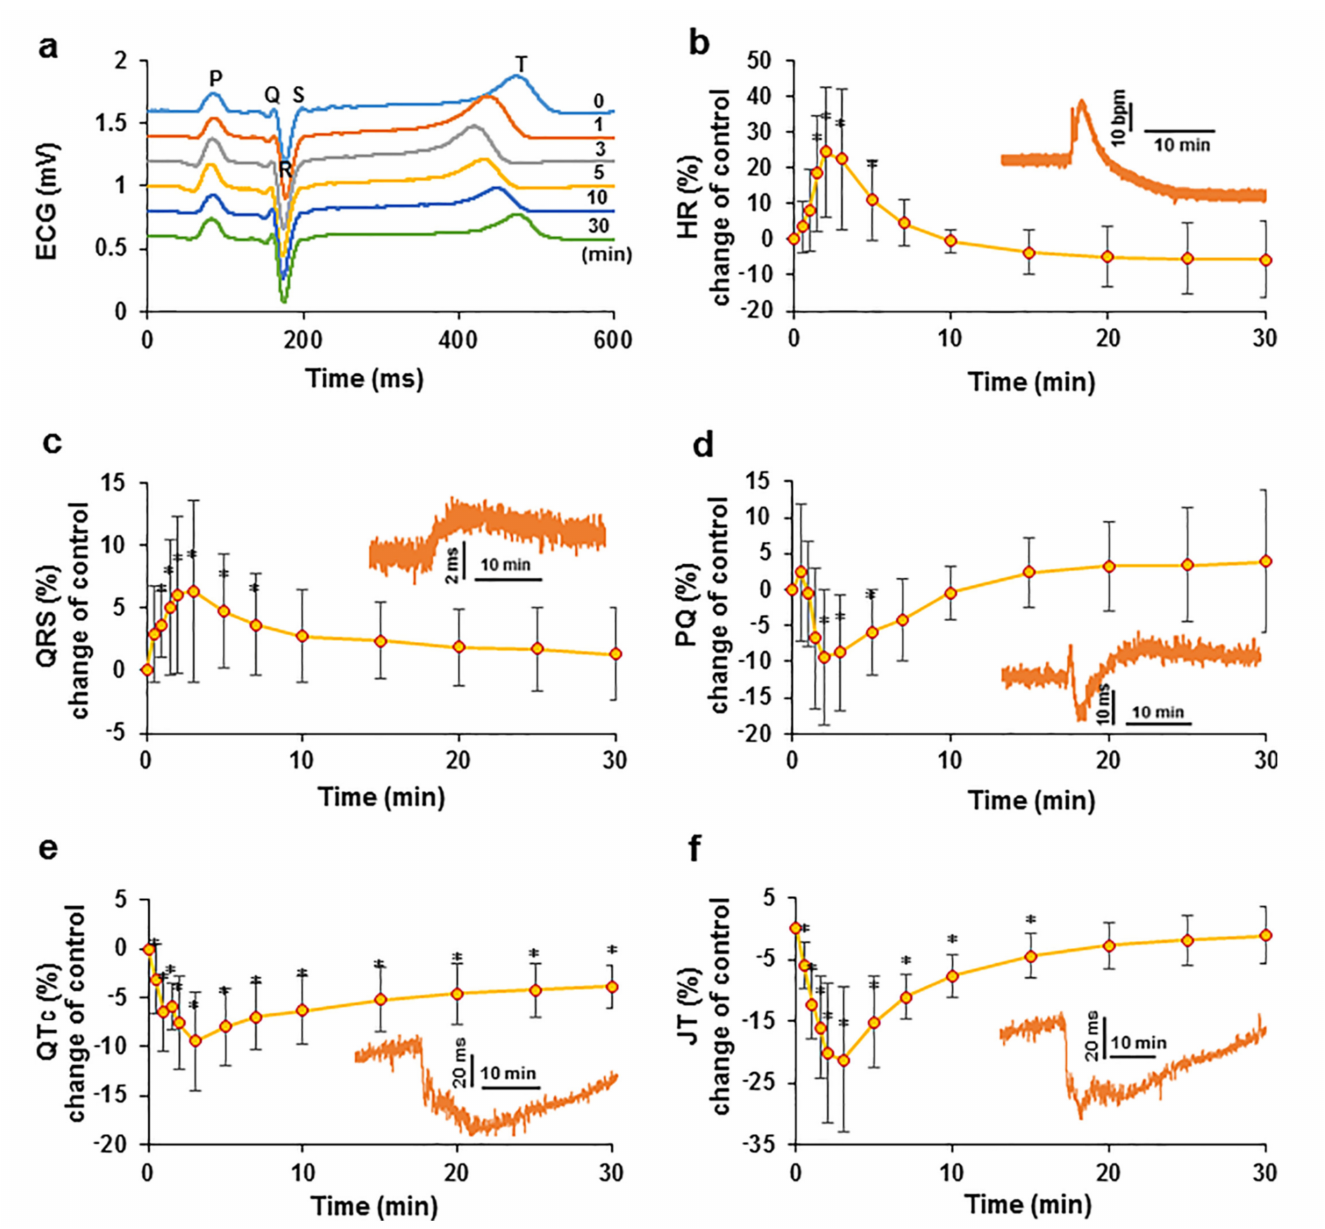
Figure 1. Effect of an intravenous injection of an EO bolus on cardiac electrical activity in swine. Changes in electrocardiogram parameters over time compared to the control: cardiac cycle ECG recordings at different times after the administration of the EO bolus ( a ); HR ( b ); QRS complex ( c ); PQ interval ( d ); QTc interval ( e ) and JT interval ( f ). The data are presented as percent changes compared to the control. The insets show data from a representative experiment. * p < 0.05 indicates a significant difference from controls, n =